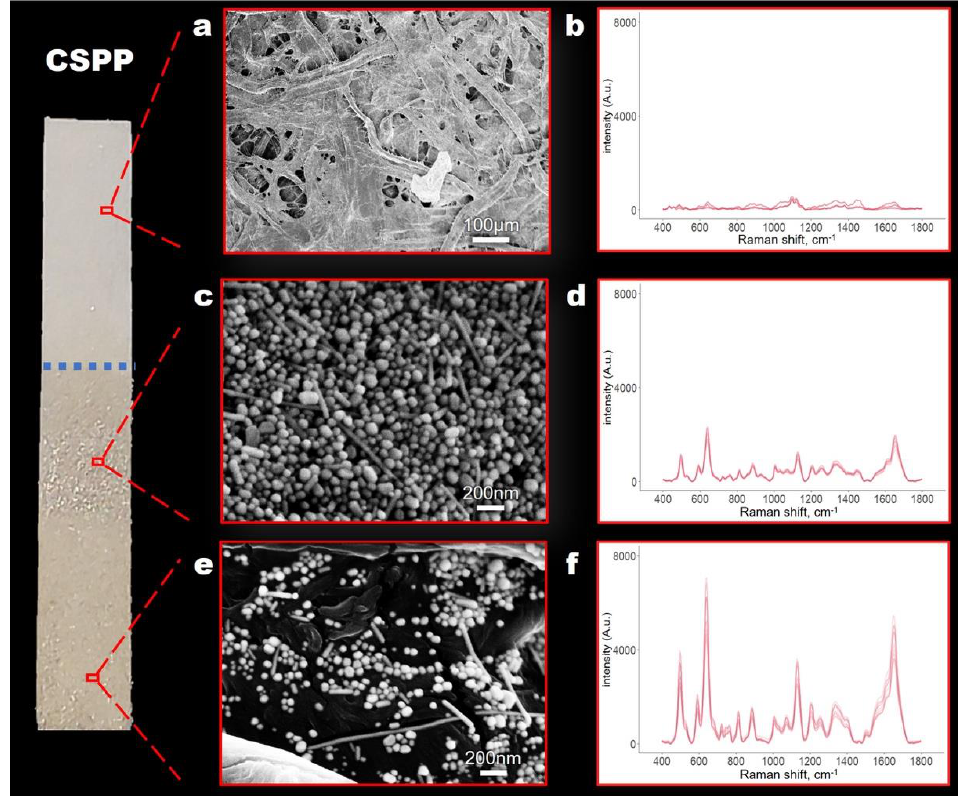
Figure 3. CSPP characterization. Scanning electron microscopy micrographs of different areas on a CSPP ( a , c , d ) and corresponding SERS spectra ( b , d , f ). See text for details.